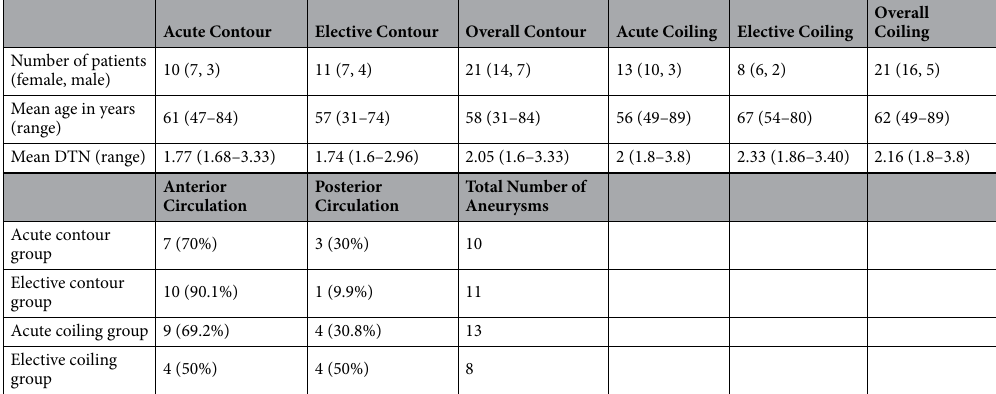
Table 1. Patient demographics and aneurysm characteristics.